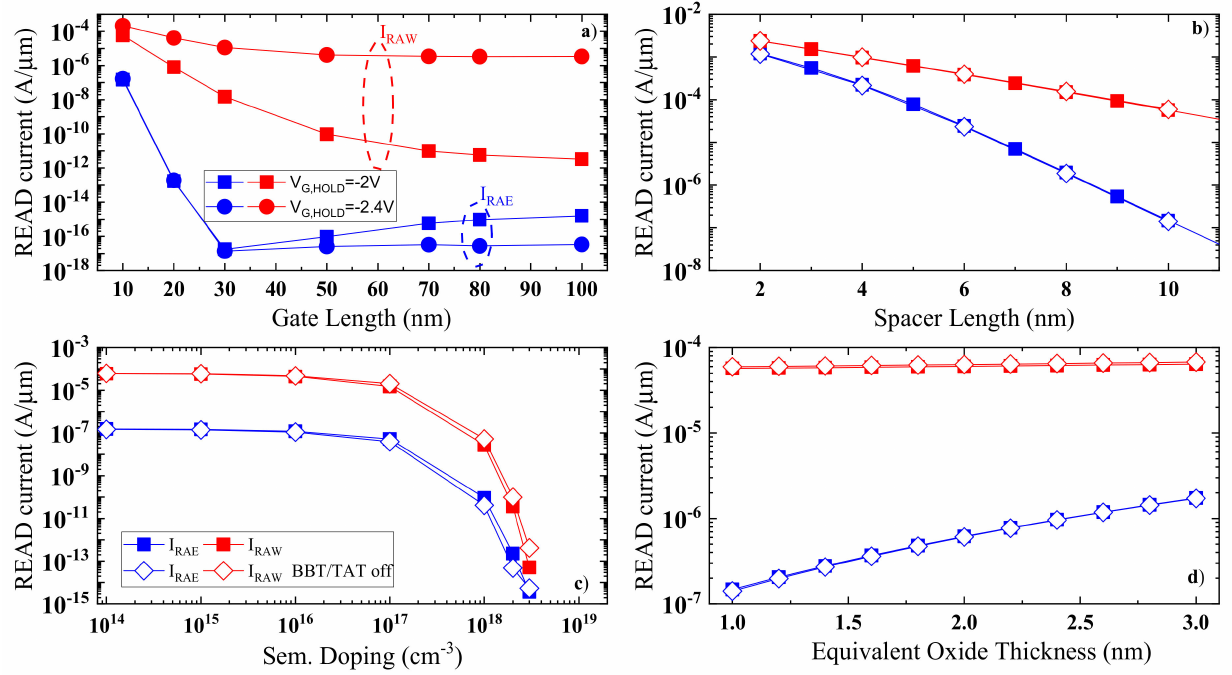
Figure 10. RAW and RAE currents, at t HOLD = 100 ms and V G,READ = − 2 V, V G,HOLD = − 2 V, as function of ( a ) gate length L; ( b ) spacer length L SP ; ( c ) semiconductor doping; and ( d ) equivalent oxide thickness (EOT). Parameters vary around the geometry discussed in Section 3 (L = W = L SP = 10 nm, WR = 20